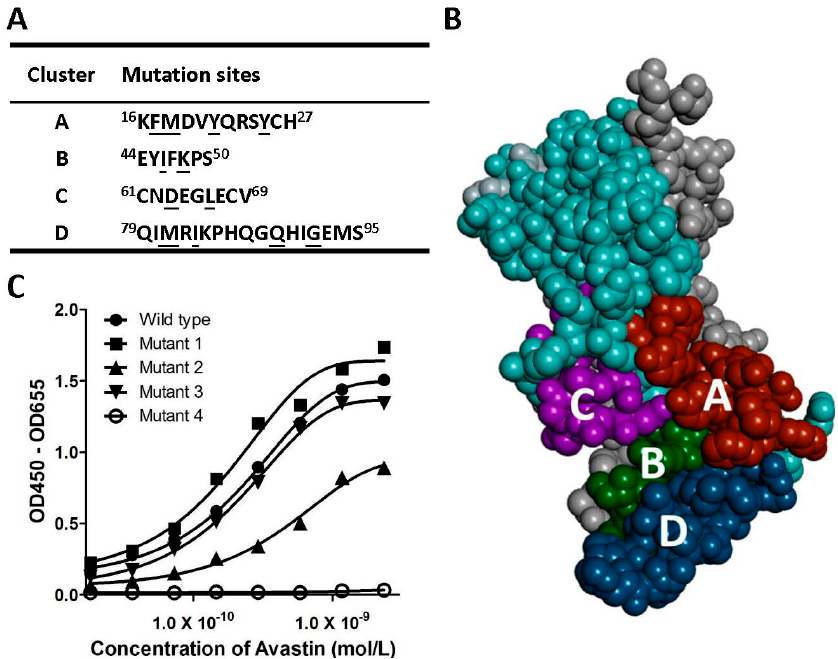
Figure 1. Cont. Figure 1.